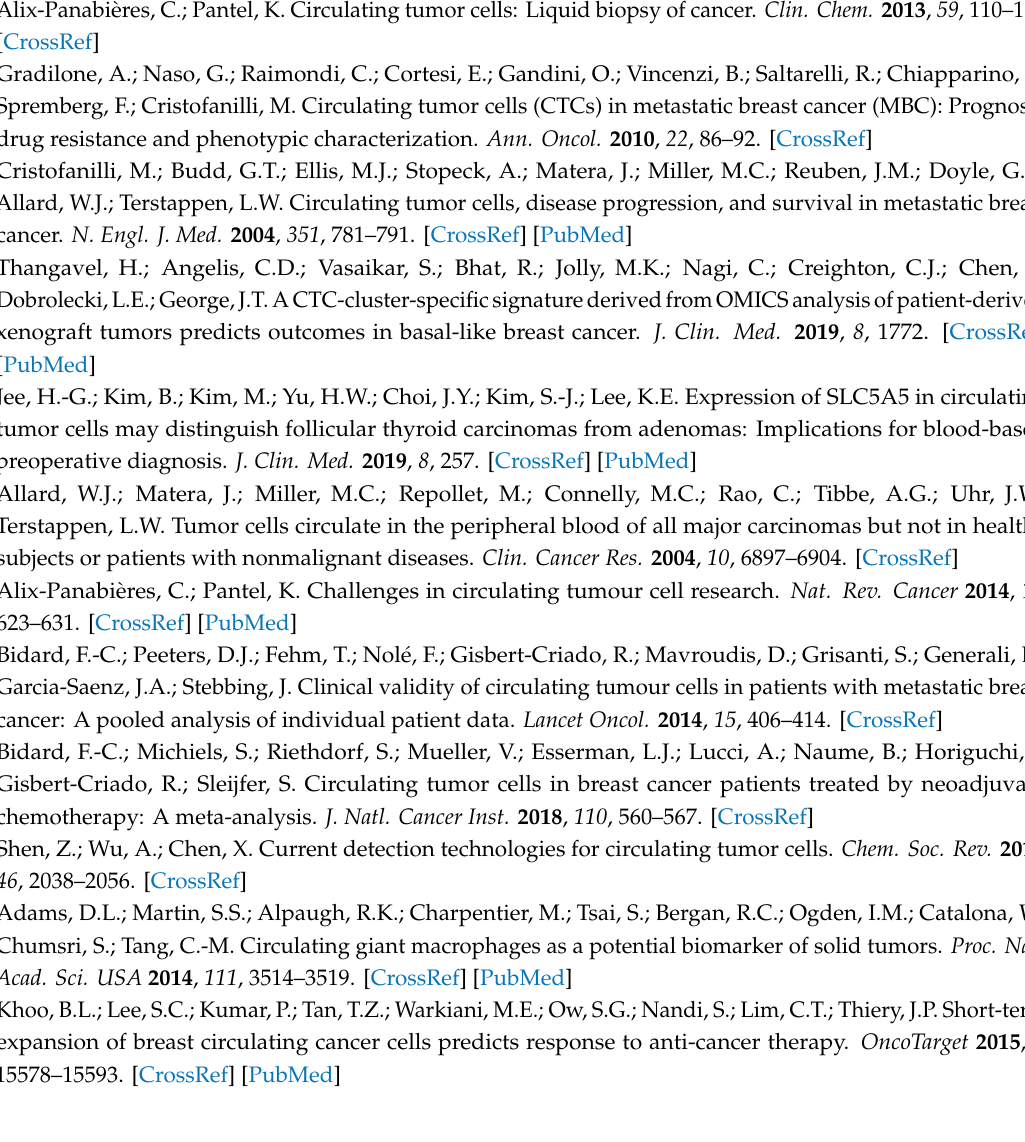
of particle size, Figure S3: Reproducibility test of functionality through carboxyl group, Figure S4: Fluorescent intensity of Alexa 488 conjugated 2nd antibody according to antibody concentration, Figure S5: Comparison of contrast in the fluorescence intensity between data from anti-EpCAM and NeutrAvidin protein, Figure S6: Cell a ffi nity comparison between particles synthesized by DML and